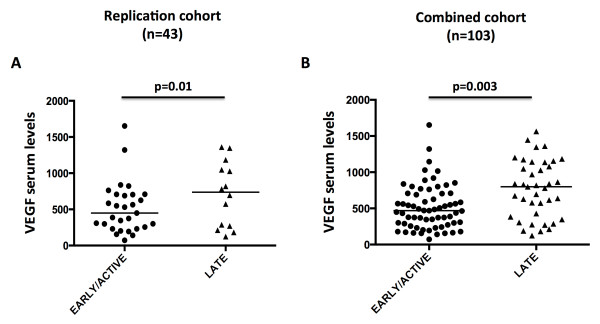
Serum VEGF levels in the replication cohort (A), and combined cohort (B), according to the nailfold videocapillaroscopy pattern.